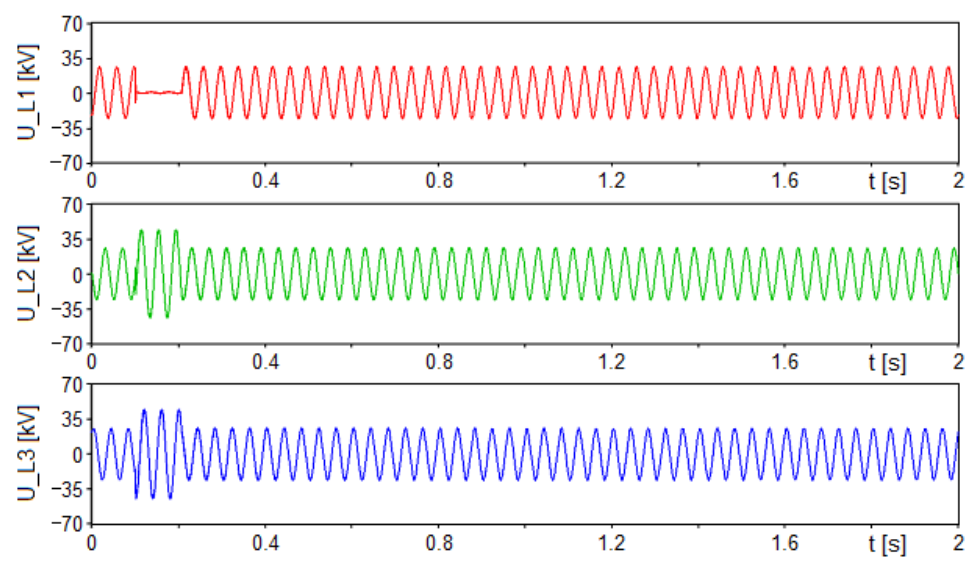
Figure 16. Waveforms of phase voltages on the primary side of voltage transformers, taking into account the presence of an earthing transformer connected to earth through a resistor R_PN = 50 Ω .